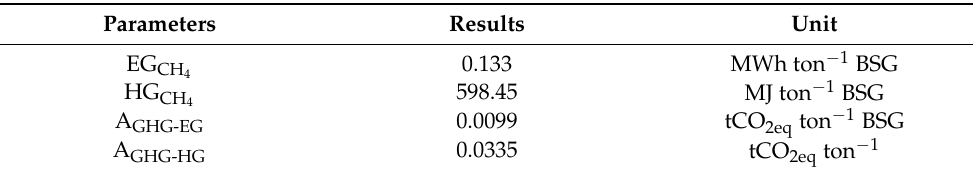
Table 4. Potential of electric energy, heat, and avoided GHG emissions using dry anaerobic digestion of